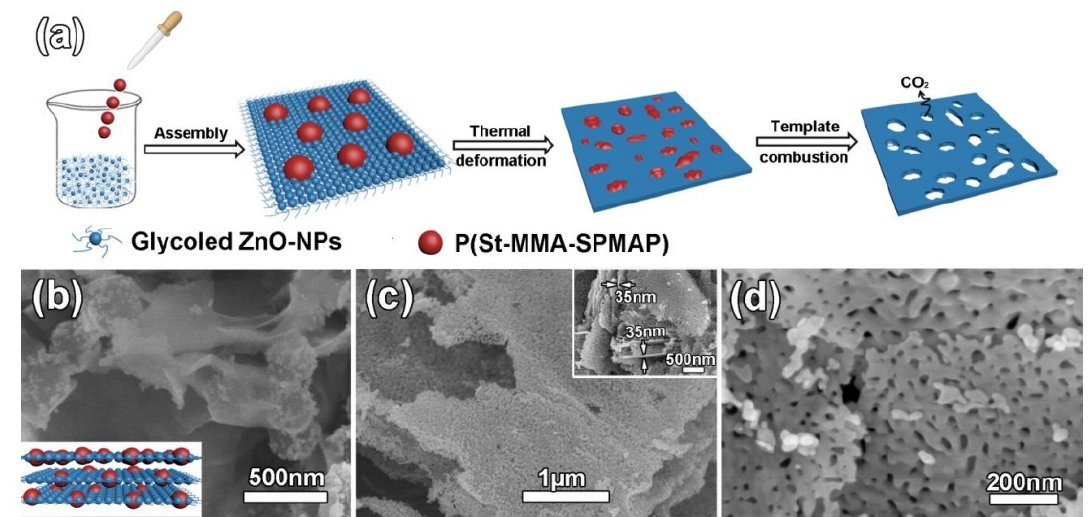
Figure 12. ( a ) Schematic illustration of the ZnO ‐ MSN synthesis, ( b ) SEM images of the layer assem ‐ bled ZnO/P(St ‐ MMA ‐ SPMAP) composites with the inset showing the perspective view of schematic image, ( c ) low magnification SEM image with the inset showing the thickness of ZnO ‐ MSN and ( d ) high magnification SEM image of ZnO ‐ MSN. Reprinted with permission from Liu et al. [98]. Copy ‐ right 2016: Elsevier.